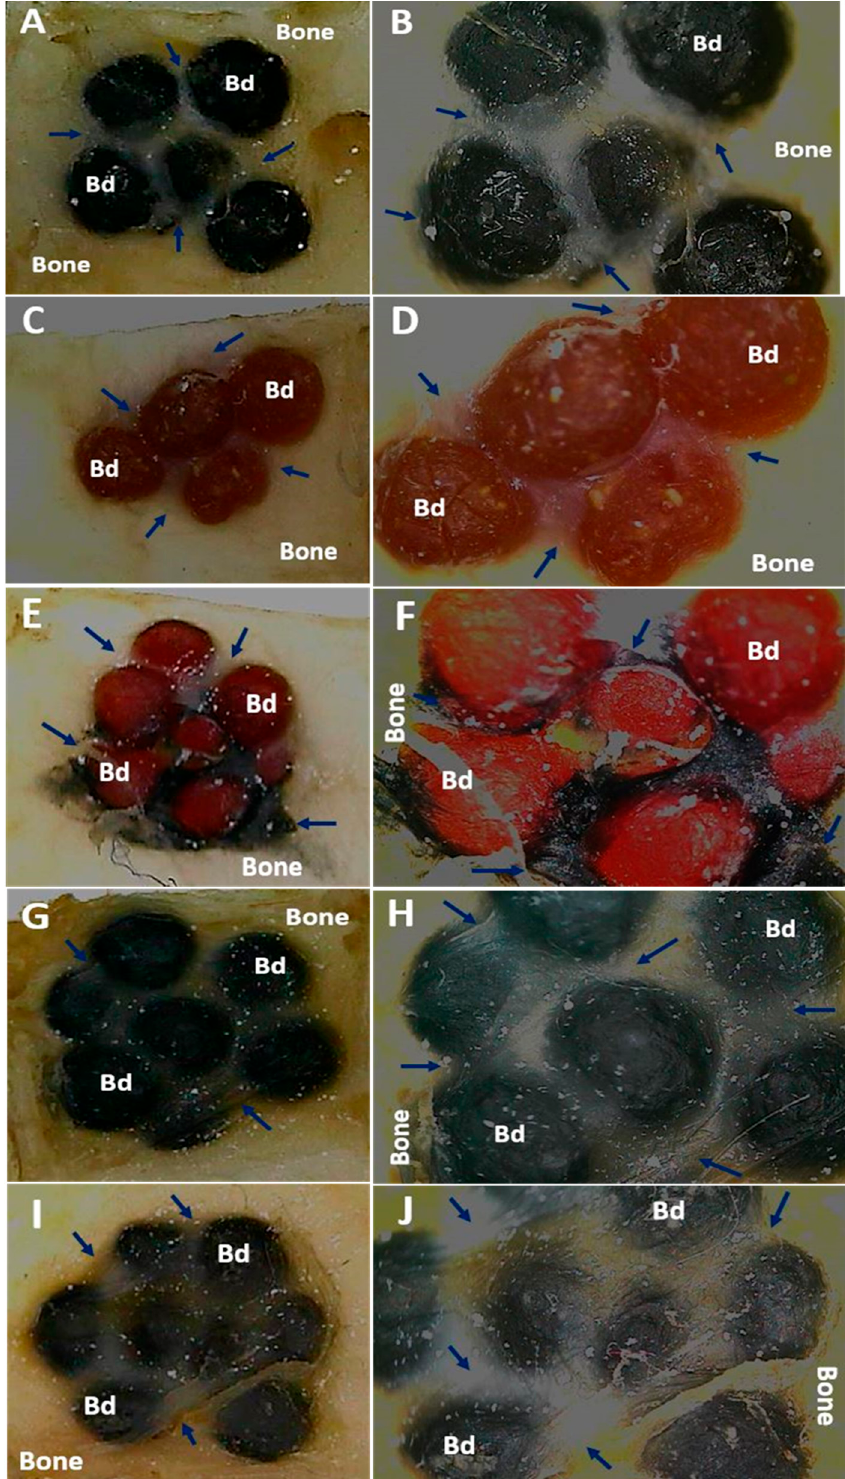
Figure 2. Cranial implantation areas. ( A ): F1 at 2×. ( B ): F1 at 3×. ( C ): F2 at 1×. ( D ): F2 at 3×. ( E ): F3 at 1×. ( F ): F3 at 3×. ( G ): F4 at 1×. ( H ): F4 at 3×. ( I ): F5 at 1×. ( J ): F5 at 3×. Bd: Bead. Blue arrows: soft tissue surrounding intervened areas. Stereoscopic microscope technique.